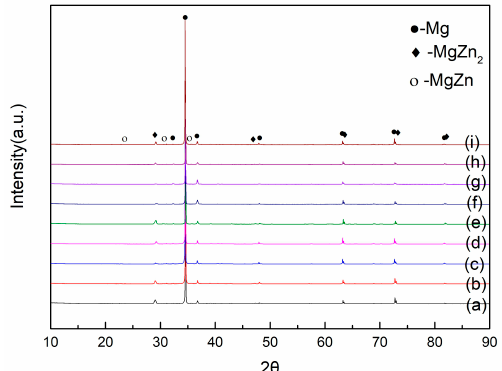
Figure 2. XRD diagram for different heat treatment conditions. ( a ) Hot rolled state; ( b ) at 170 °C for 4 h; ( c ) at 170 °C for 12 h; ( d ) at 170 °C for 28 h; ( e ) at 400 °C for 3 h; ( f ) at 400 °C for 3 h and 170 °C for 12 h; ( g ) at 400 °C for 3 h and 170 °C for 24 h; ( h ) at 400 °C for 3 h and 170 °C for 28 h; ( i ) at 190 °C for 12 h.